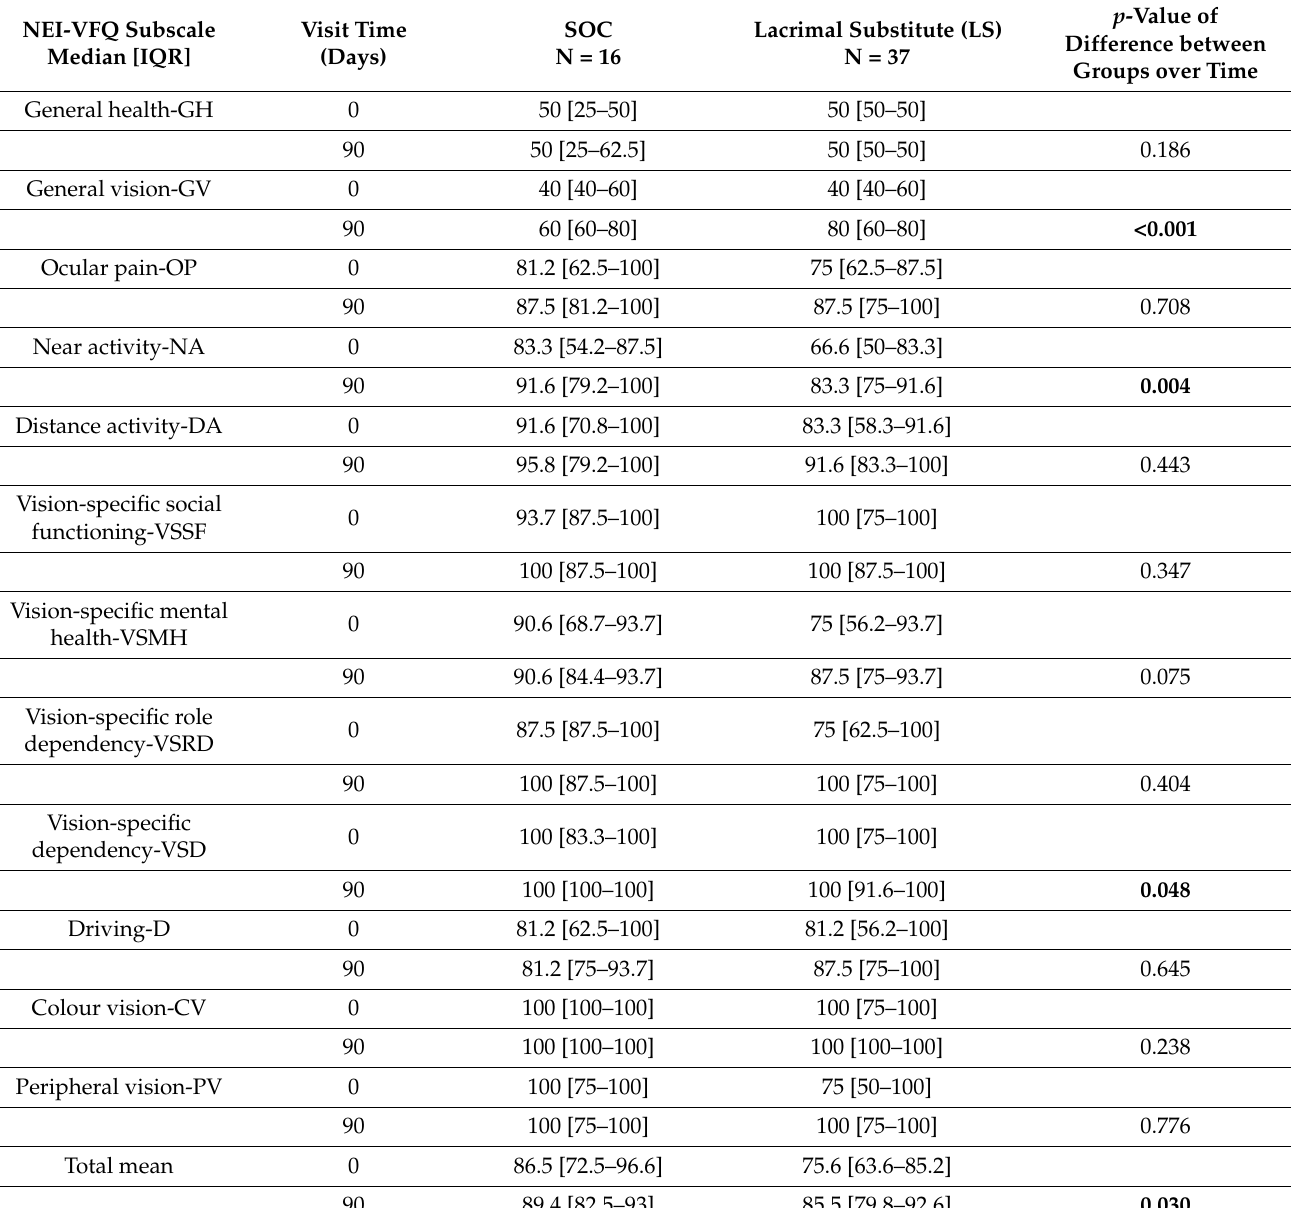
Table 3. NEI-VFQ 25 item: scores at baseline (0) and three months later 90 days. Statistically significant values are on